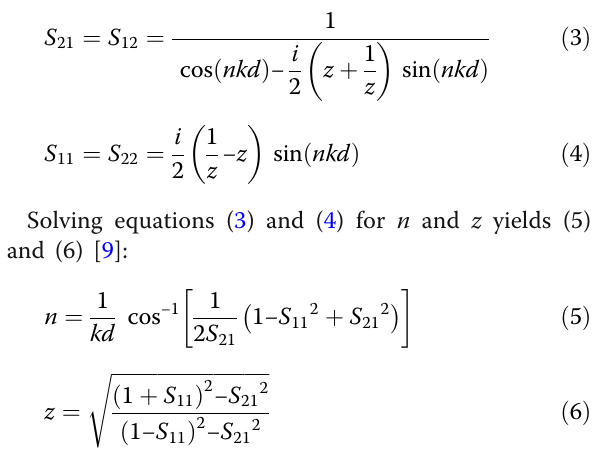
The design principle of the antenna revolves mainly around equation (5) which gives the expres- sion for the refractive index as a function of the re- flection and transmission S parameters and the slab length d . The application of equation (5) is first per- formed over a single-unit cell of the arc-shaped par- asitics (ASP) as shown in Fig. 11. The unit cell is excited by waveguide ports excited on the two faces of the dielectric slab on which the ASP is printed. On running the simulation in a full-wave solver for the desired frequency of interest, the S and S 11 21 values can be obtained. The length of the arc of the ASP is 1.7 mm, around λ /10 at 14 GHz. Of the total 10 ASPs selected to enhance the end- fire gain, five are on the left side of the endfire axis and the other five are symmetrically on to the other side. Equation (5) is used to calculate the refractive index as illustrated in Fig. 12 which depicts the way the refractive indices were calculated starting from the endfire central axis, towards the extreme left. Since the structure is symmetrical across the endfire axis, the same calculation of the refractive index holds for the right side as well. From Fig. 12, starting from the extreme right, i.e. the central ASP, setting up the S parameter extraction and retrieval of the refractive index on the full-wave solver returns values specific to the band of interest and length of the slab ( d ) equal to 1 mm. This pro- cedure is repeated for other four cases of d = 1.5, 2, 2.5 and 3 mm. The distance along the x -axis in Fig. 12 is not to scale, it is a pictorial depiction for clarity purposes of describing the setup. This methodology extracts the real part of the refractive index for this kind of unit cells in a sequential way. Their values as a function of frequency are plotted in Fig. 13, where the real part of the refractive index variation on